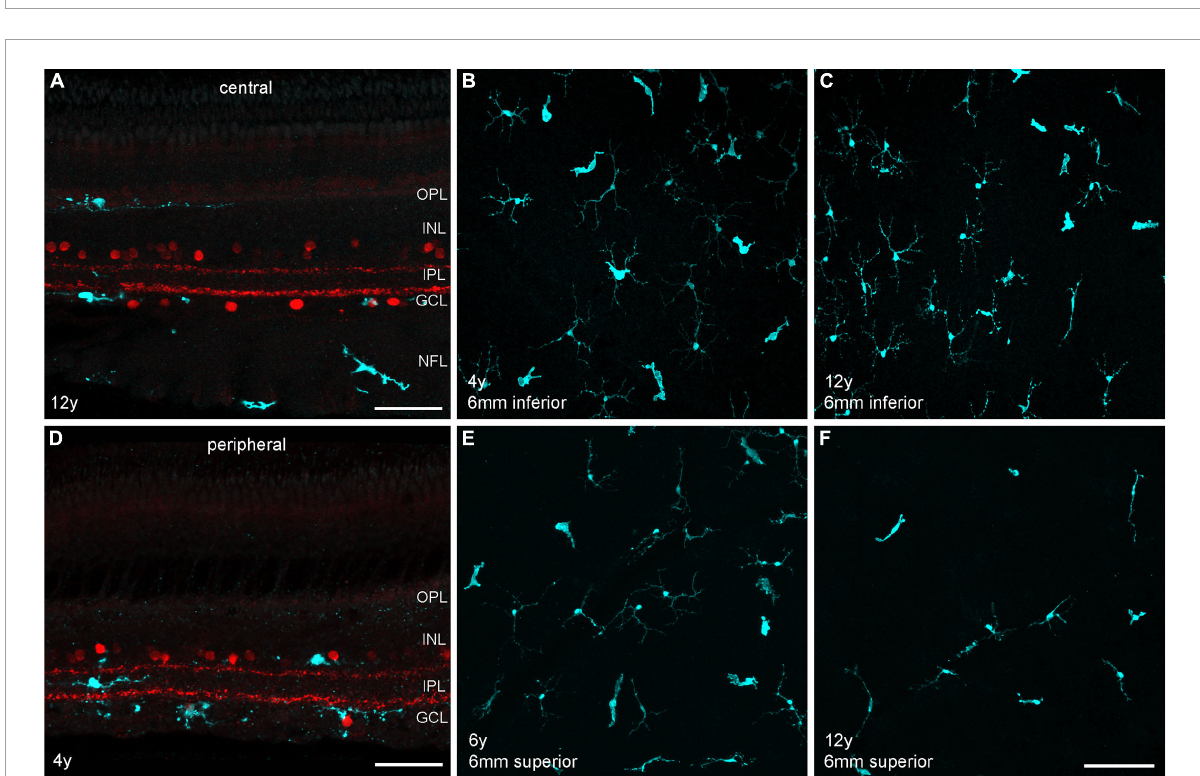
FIGURE7 Microglia staining in different retinal areas of control and aged marmosets. (A) Central vibratome section of a 12-year-old male, double labeled with Iba1 (cyan) and ChAT (red). Microglia are primarily visible in the outer retina in the OPL and in the inner retina in the GCL and nerve fiber layer (NFL). (B,C) Whole mount projections of microglia at 6 mm inferior from control and aged marmosets (4, 12 years). (D) Peripheral vibratome section of a 4-year-old male, same labeling as in (A) . Microglia are primarily distributed in the inner retina among ChAT+ cells in the INL and GCL and in between in the IPL. (E,F) Whole mount projections of microglia at 6 mm superior from control and aged marmosets 6, 12 years). Scale bars, in (A,D) 50 µ m, in (F) 100 µ m for (B,C) and (E,F) .